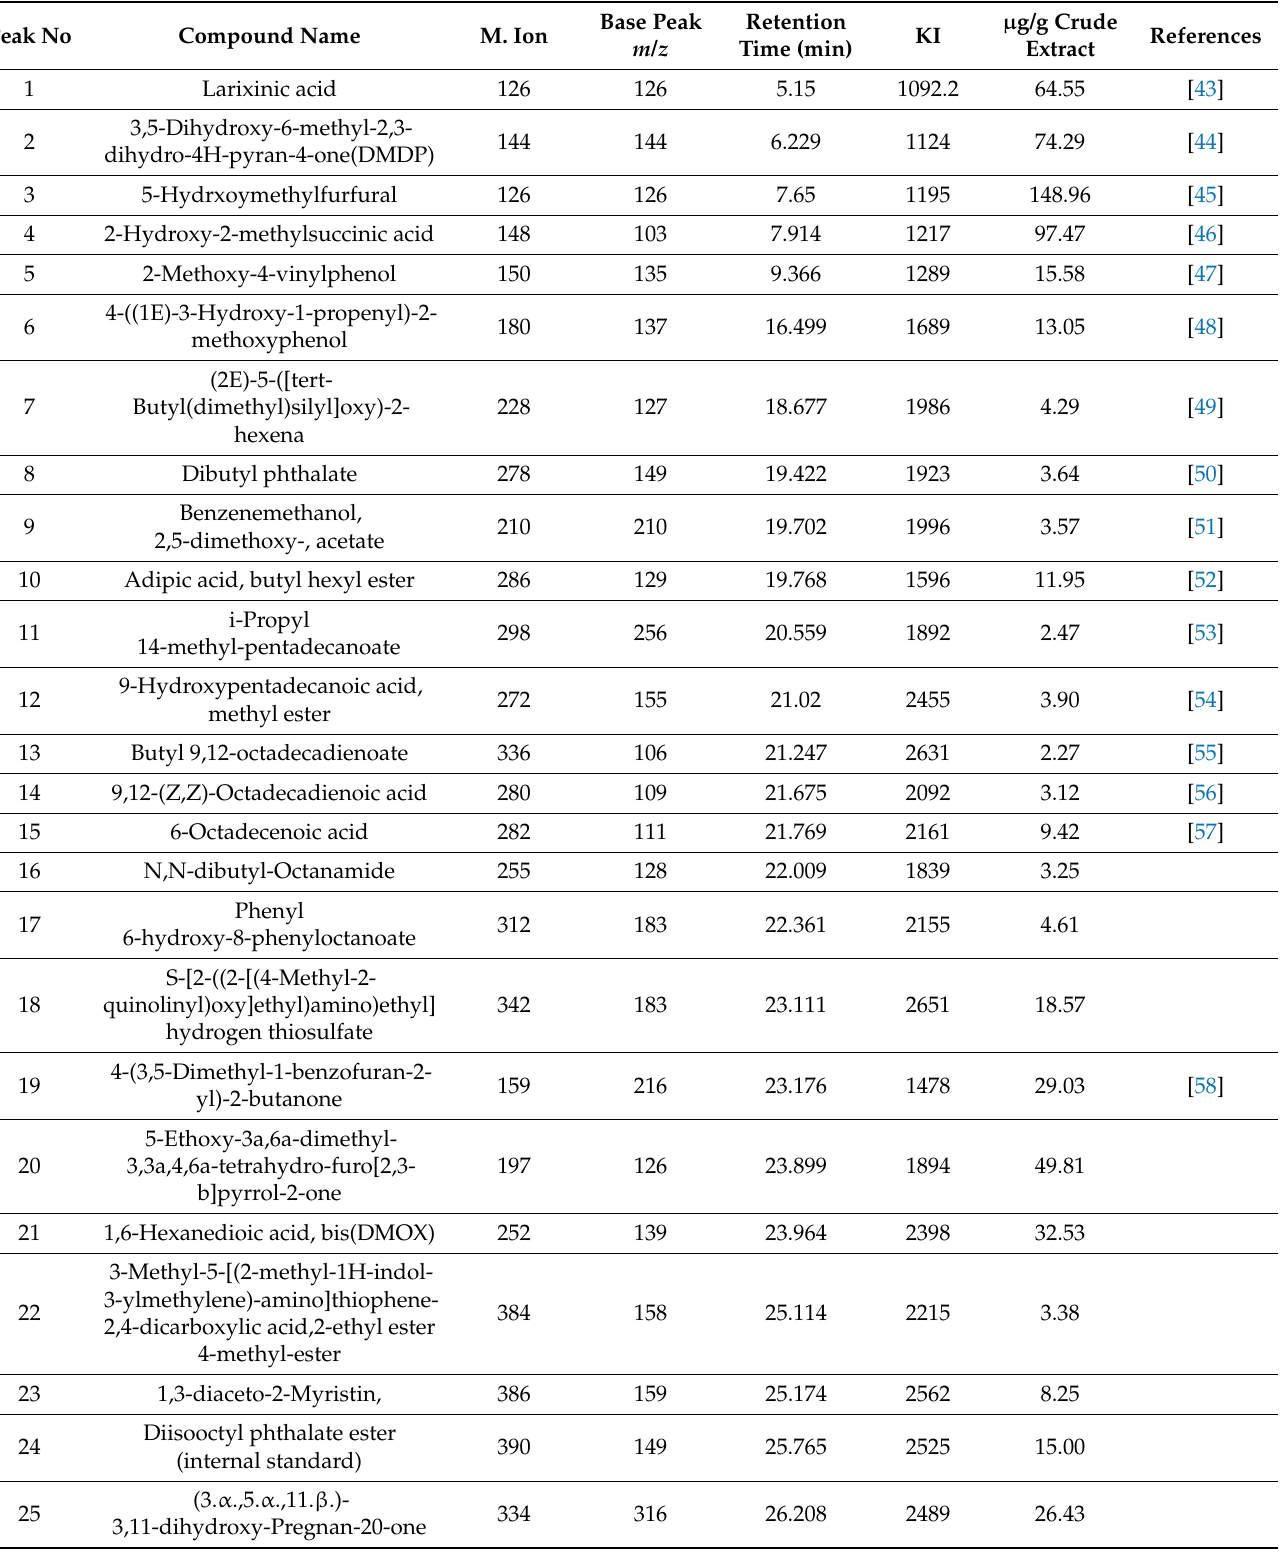
Table 6. Phytochemical compounds identified by GC-MS in methanolic extracts of mature (K m ) fruits of K. pinnata